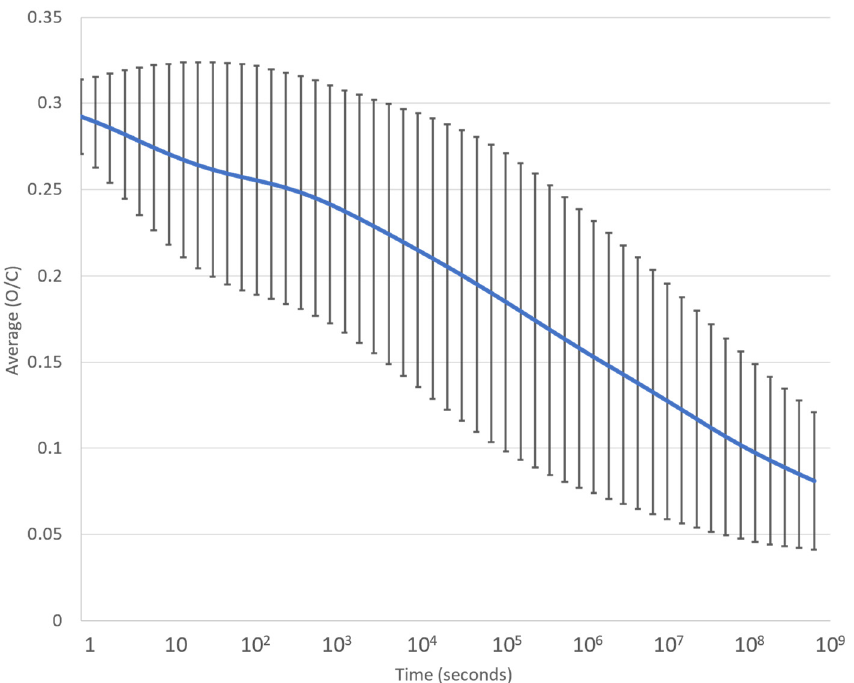
Figure 3. Oxygen content of the chemical space of stable compounds declines with exposure to concentrated sulfuric acid. y axis: Average of O/C content of the chemical space after reaction in sulfuric acid under proposed stratospheric conditions. x axis: time. Error bars are the standard deviation of the average O/C value across the range of conditions considered.